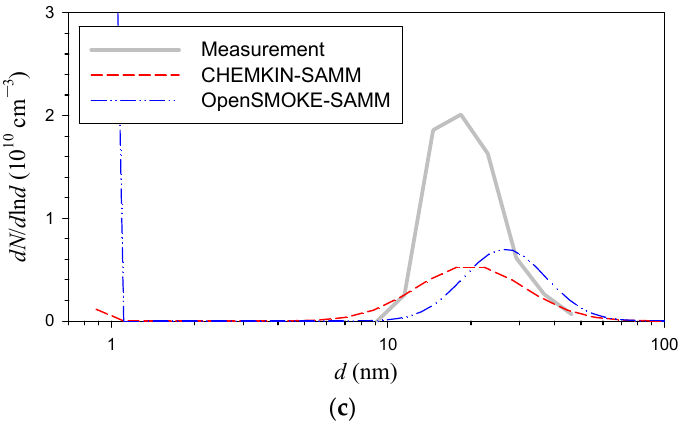
Figure 5. Comparison of soot particle size distributions predicted by CHEMKIN-SAMM and OpenSMOKE-SAMM with measured data at different residence times in the PFR: ( a ) 4.1 ms, ( b ) 8.5 ms, and ( c ) 12.9 ms.